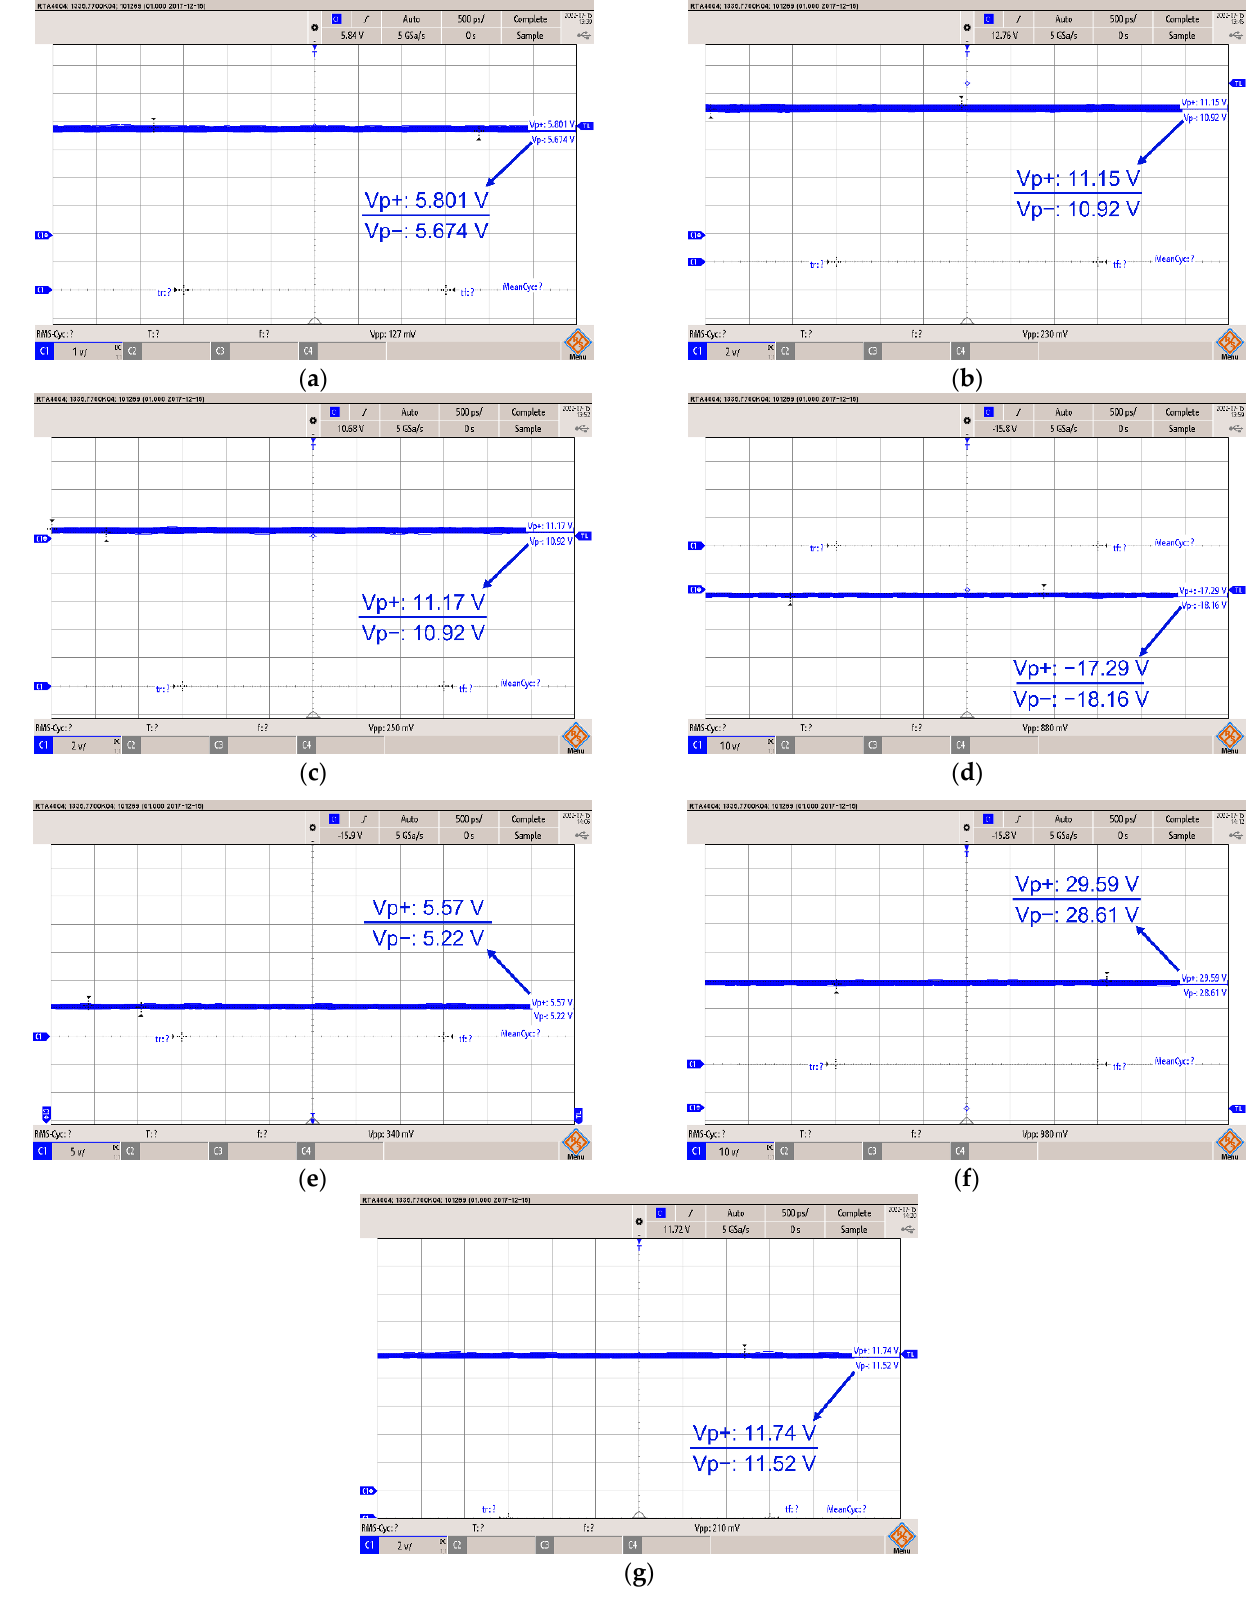
Figure 12. Voltages across capacitors at D = 0.5 and V in = 3V. ( a ) Voltage across C 1 , ( b ) voltage across C 2 , ( c ) voltage across C 3 , ( d ) voltage across C 4 , ( e ) voltage across C 5 , ( f ) voltage across C 6 , and ( g ) voltage across C 7.